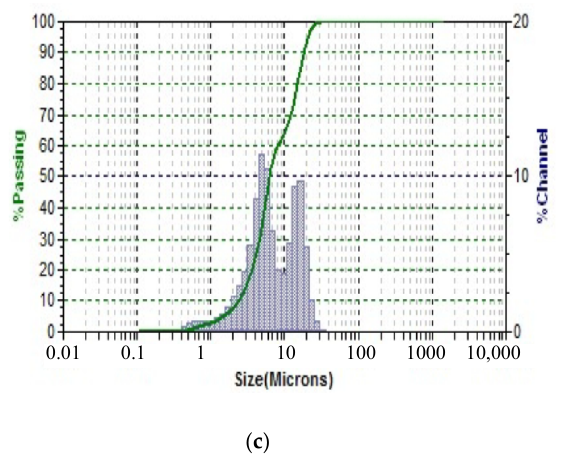
Figure 3. The particle size distribution of ( a ) uncalcined Ba 0.5 AlO x , and Ba 0.5 AlO x powders calcined at ( b ) 200 °C and ( c ) 400 °C.